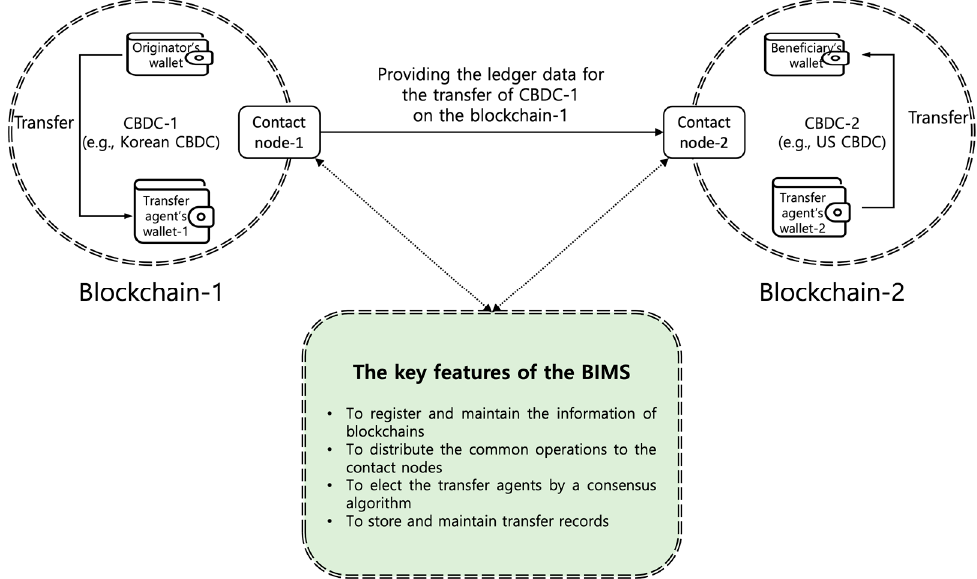
Figure 5. The service model for the transfer between CBDC-1 and CBDC-2.